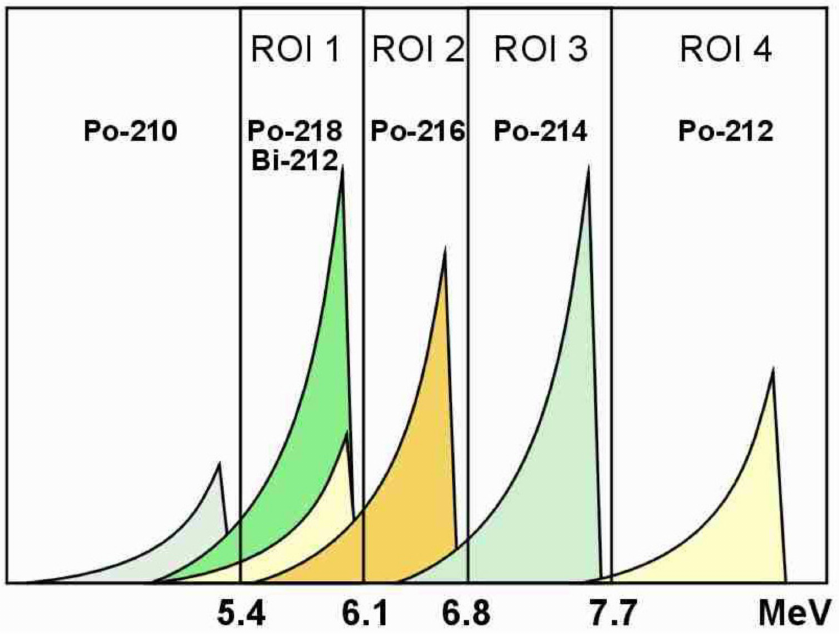
Figure 3. Definition of four ROIs assigned to the various nuclides (application note